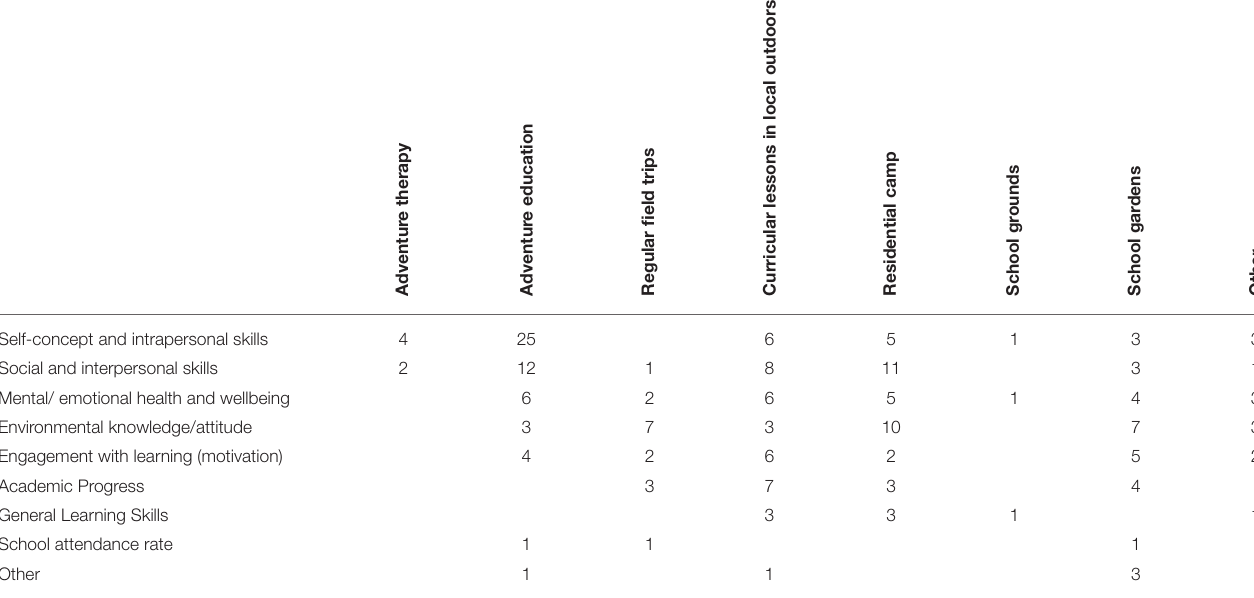
TABLE 3 | Number of studies by outdoor learning context and measured outcome.